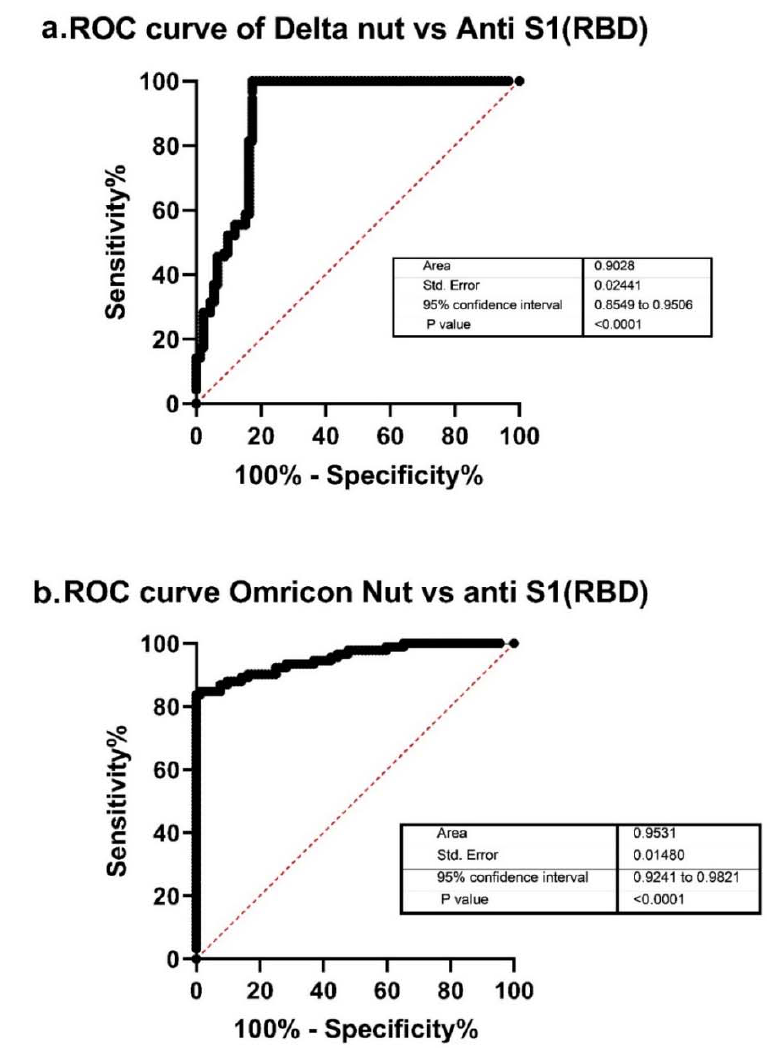
Figure 5. ROC of Delta neutralizing (nut) antibody and anti-S1 (RBD) antibody titers ( a ) and Omicron neutralizing (nut) antibody and anti-S1 (RBD) antibody titers ( b ).